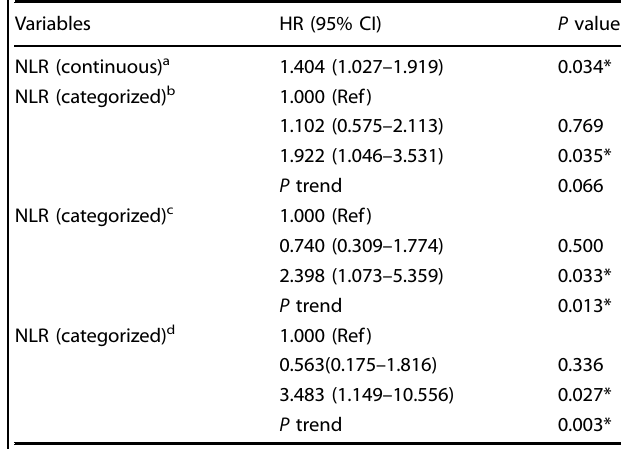
Table 4. Univariate Cox proportional-hazards regression analyses for survival.